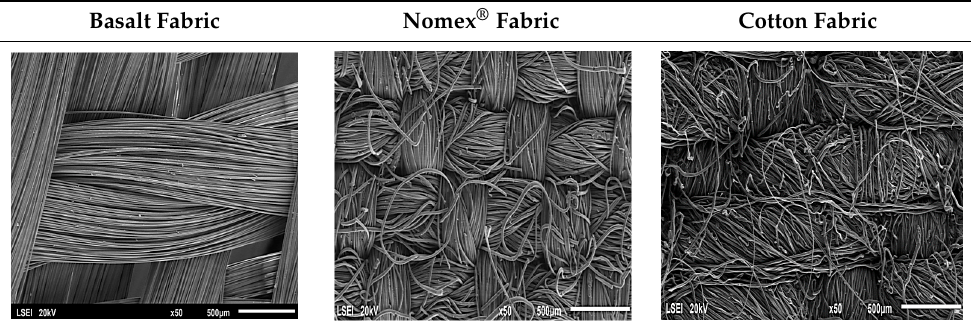
Table 1. SEM images of fabrics.